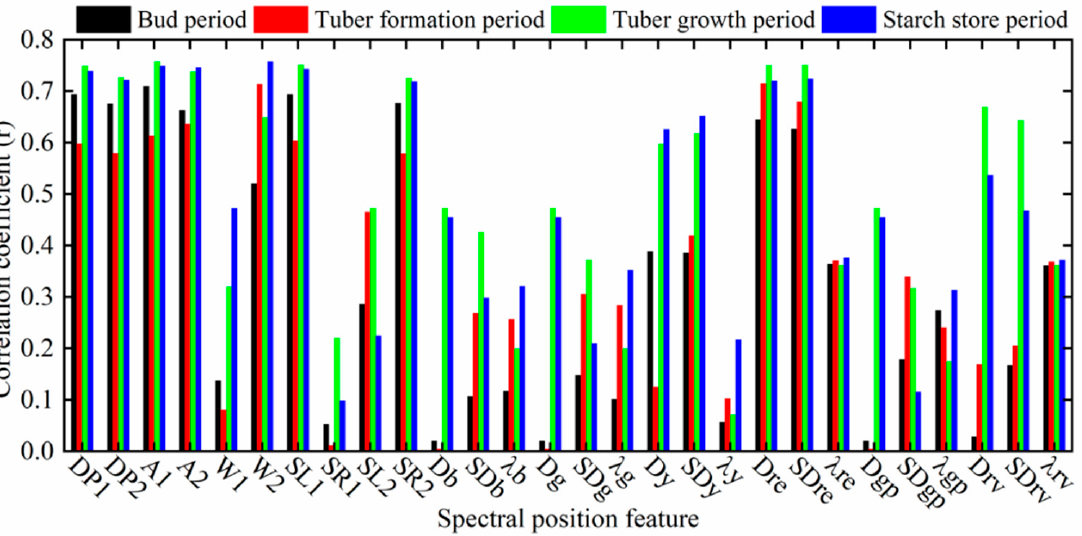
Figure 9. Correlation coefficients of spectral-position features for measured potato AGB at bud period, tuber-formation period, tuber-growth period, and starch-storage period.